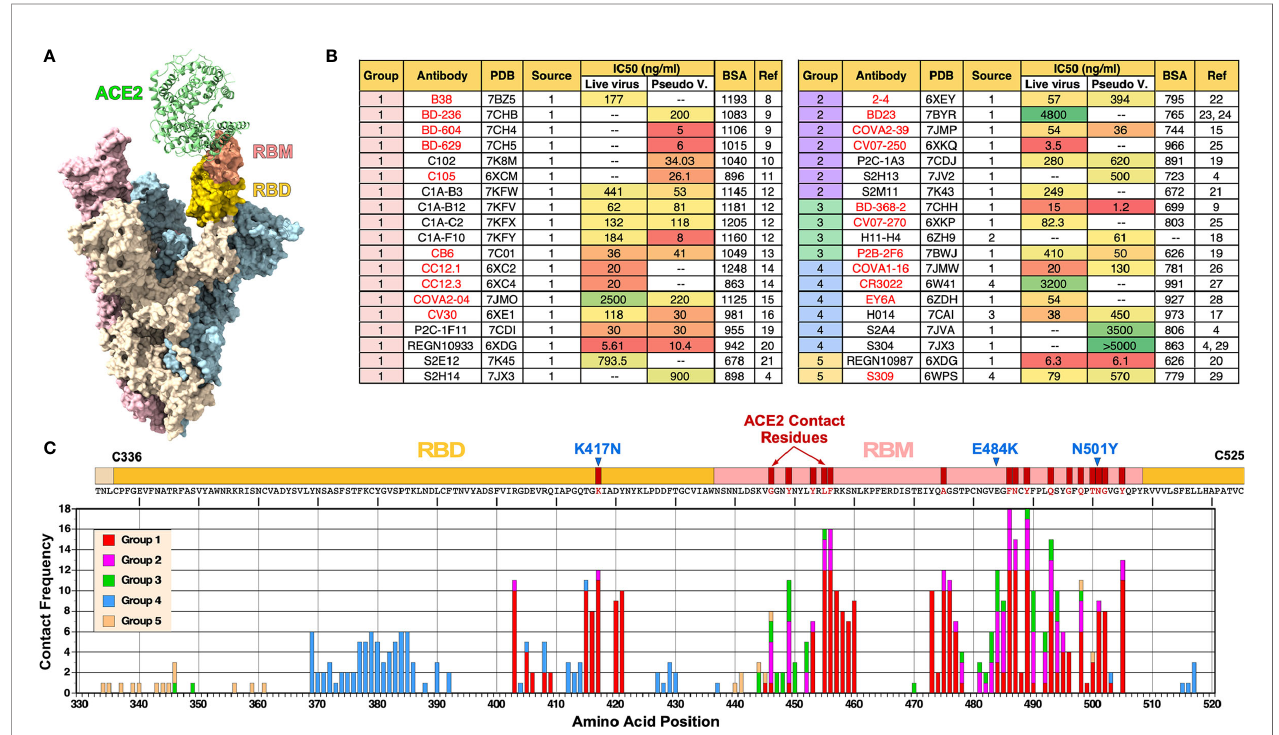
FIGURE 1 | Summary of nAbs against SARS-CoV-2 RBD. (A) Cryo-EM structure of trimeric spike glycoprotein (PDB: 7A97). One of the monomers (beige) with ACE2 bound has its RBD and RBM colored in gold and salmon, respectively. (B) Antibodies are organized by their cluster group. Antibody source (1: COVID-19 patients; 2: Llama antibody library; 3: SARS-CoV RBD immunized mice; 4: SARS-CoV patients), IC 50 and buried surface area (BSA) are shown. IC 50 was converted from nM using ~150 kd molecular weight for the following mAbs: H014, REGN10933, REGN10987, S2M11S2E12, S309. BSA values were either obtained from a previous review (5) or calculated using PISA (6). Antibodies shown in red text have been previously described (5). (C) Frequency of nAbs making contact with each amino acid in the RBD. Each group is represented by different colors. Contact residues were identi fi ed using “ Clashes/Contacts ” tool in UCSF Chimera using default settings. Three RBD mutations present in SARS-CoV-2 B.1.351 variant (K417N, E484K and N501Y) are